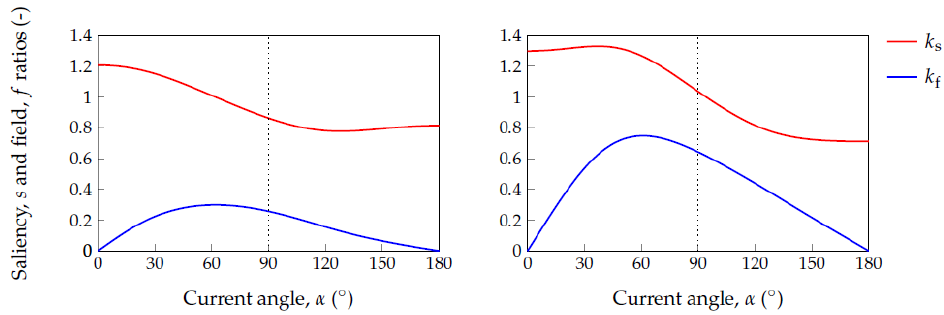
Figure 7. WF-FMM absolute saliency and field ratios characteristics of ( left ) WF-FSM and ( right ) DC-VRM at rated currents (phase and field) and different operating points defined by the current